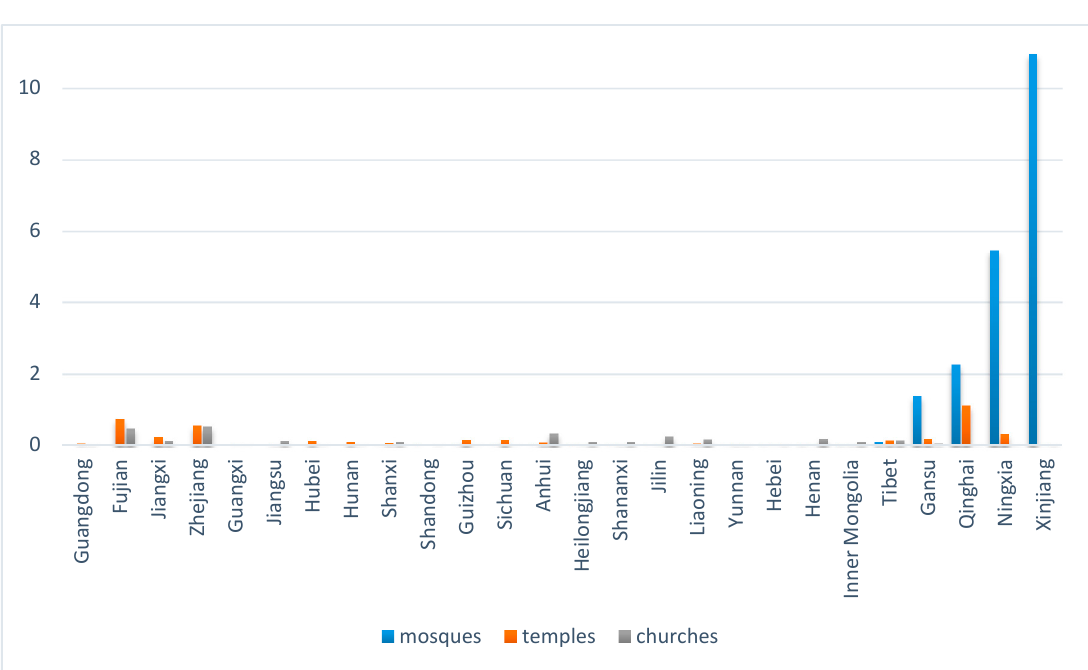
Figure 1. Number of religious sites per 10,000 people in 25 provinces in China. The average GDP per capita is 25,638.77 RMB ( ≈ $3845.82) with the minimum and maximum being 10,301.95 RMB ( ≈ $1586.92) and 44,604.92 RMB ( ≈ $6862.30), and economic inequality, measured by the Theil index, also varies across provinces, from 0.063 (Zhejiang) to 0.489 (Guangdong). The average urban population in the provinces is about 47 percent, with the minimum and maximum being 29.9 percent (Guizhou) and 63.4 percent (Guangdong), respectively. The illiteracy rate is, on average, 7.2 percent, with the rate ranging from 3.2 percent (Liaoning) to 15.9 percent (Gansu), whereas the percentage of ethnic minorities varies widely across provinces, from 0.3 percent (Jiangxi) to 59.4 percent (Xinjiang). Finally, the percentage of Communist Party members in provinces is, on average, 11.4 percent, ranging from 7.0 percent (Hebei) to 25.3 percent (Qinghai). Table 2 presents results from estimating multi-level models that include both the individual-level and provincial-level independent variables. Consistent with Hypothesis 1, respondents a ffi liated with Islam report lower odds of violating the law ( − 0.666), workplace rules ( − 0.498), and organizational rules ( − 0.781) compared to those without a religious affiliation. However, the odds of violating transportation laws are not significantly lower for Muslims and the odds of violating government laws is only marginally signi fi cant ( − 0.435, p = 0.072). Buddhists also report lower odds of violating the law ( − 0.245), workplace rules ( − 0.256), government laws ( − 0.292), and transportation laws ( − 0.341), but are not different from religious nones in terms of their odds of violating organizational rules. Respondents affiliated with Christianity are not different from religious nones in the odds of all types of violations. In sum, contrary to previous findings that religion has no protective effect on deviance in China (Stark 2001; Zhang and Thomas 1994; Zhang and Xu 2007), we find some evidence that Islam and Buddhism, though not Christianity, have a deterrent effect on deviance in China. Thus, Hypothesis 1 received some support. Table 2. Religion as an individual and contextual control (individual N = 8224; province N = 25). (1) Violating the Law